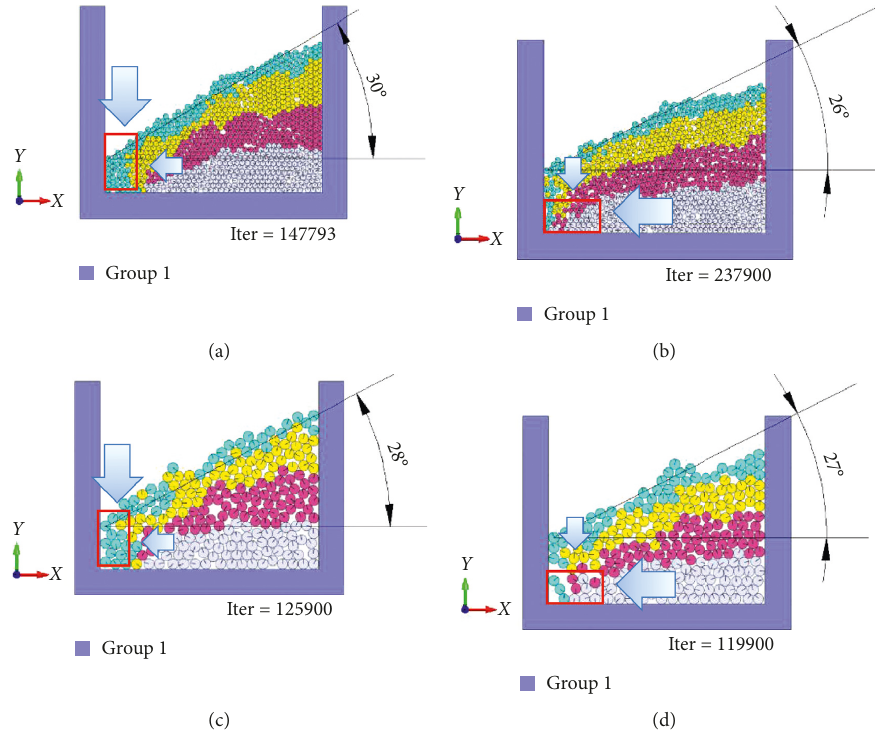
Figure 9: Relationship between excavation shape and coal collapsed body. (a) 0.1 m particle size and 1m × 0.5m excavation. (b) 0.1m particle size and 0.5 m × 1m excavation. (c) 0.2m particle size and 1 m × 0.5 m excavation (d) 0.2m particle size and 0.5m × 1m